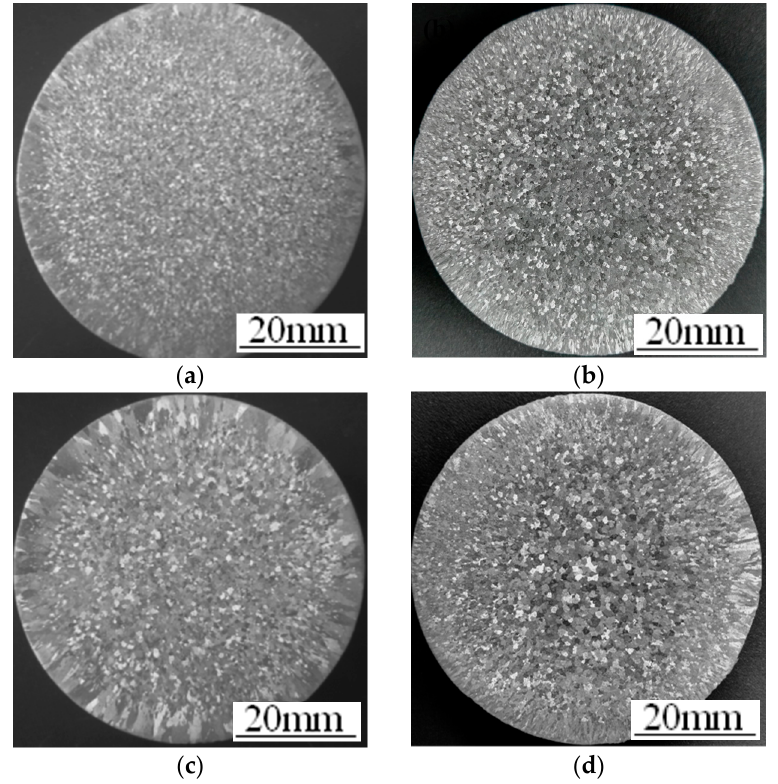
Figure 6. Effects of holding time on refinement effect of pure aluminum refined with 0.3% Al-5Ti-0.62C-0.2Ce master alloy: ( a ) 30 min; ( b ) 60 min; ( c ) 90 min; and ( d ) 120 min.